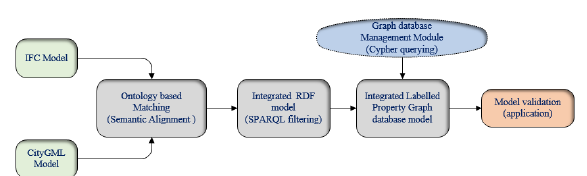
Figure 1. BIM-GIS semantic integrated model conceptual design